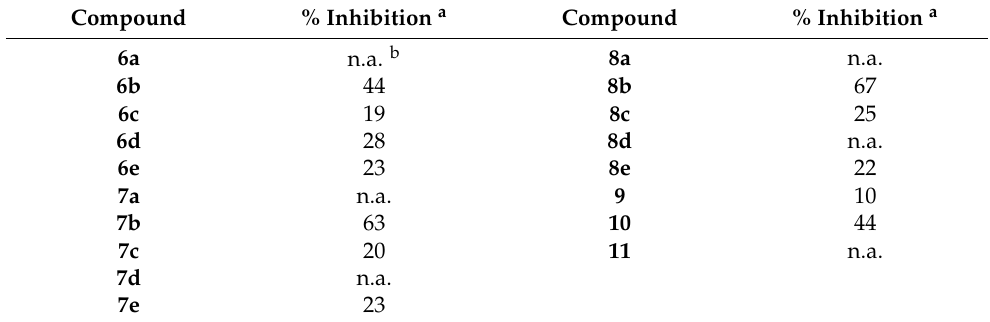
Table 2. ALR2 inhibitory activities of ( E )-benzaldehyde O -benzyl oximes 6a–e , 7a–e , 8a–e , and 9–11 . Compound % Inhibition a